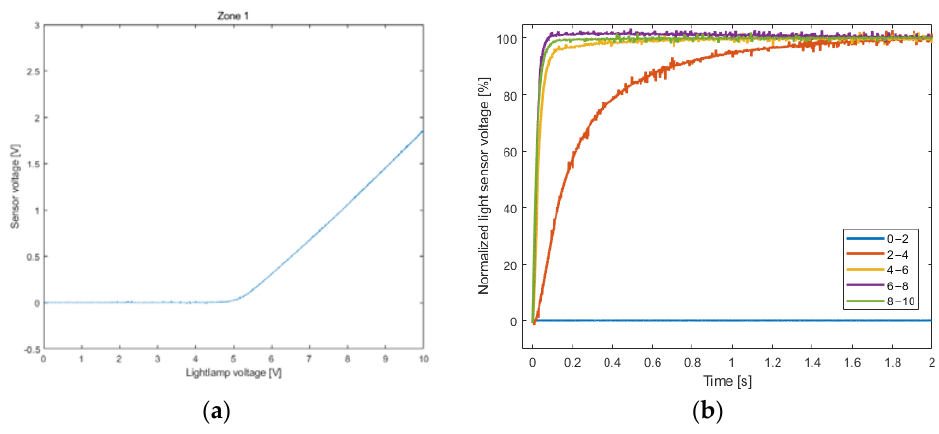
Figure 2. System characteristics before calibration: ( a ) static characteristics of zone 1; ( b ) normalized staircase experiment of zone 1.